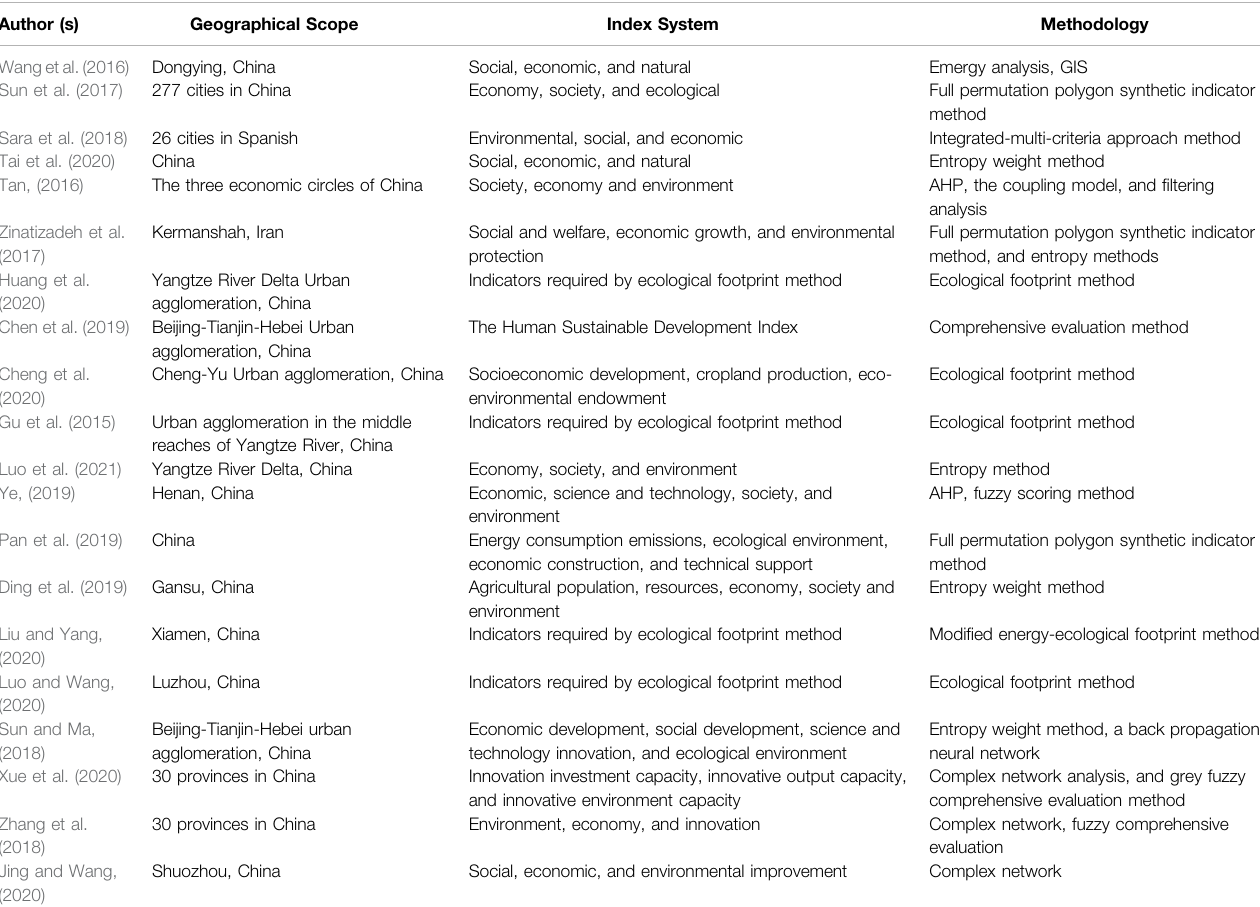
TABLE 1 | Overview of relevant